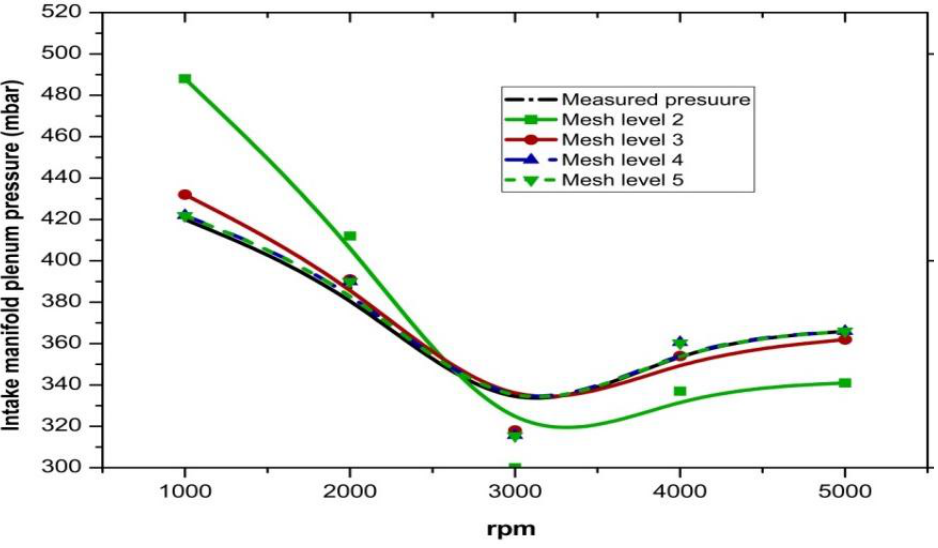
Figure 5. Computational meshing.